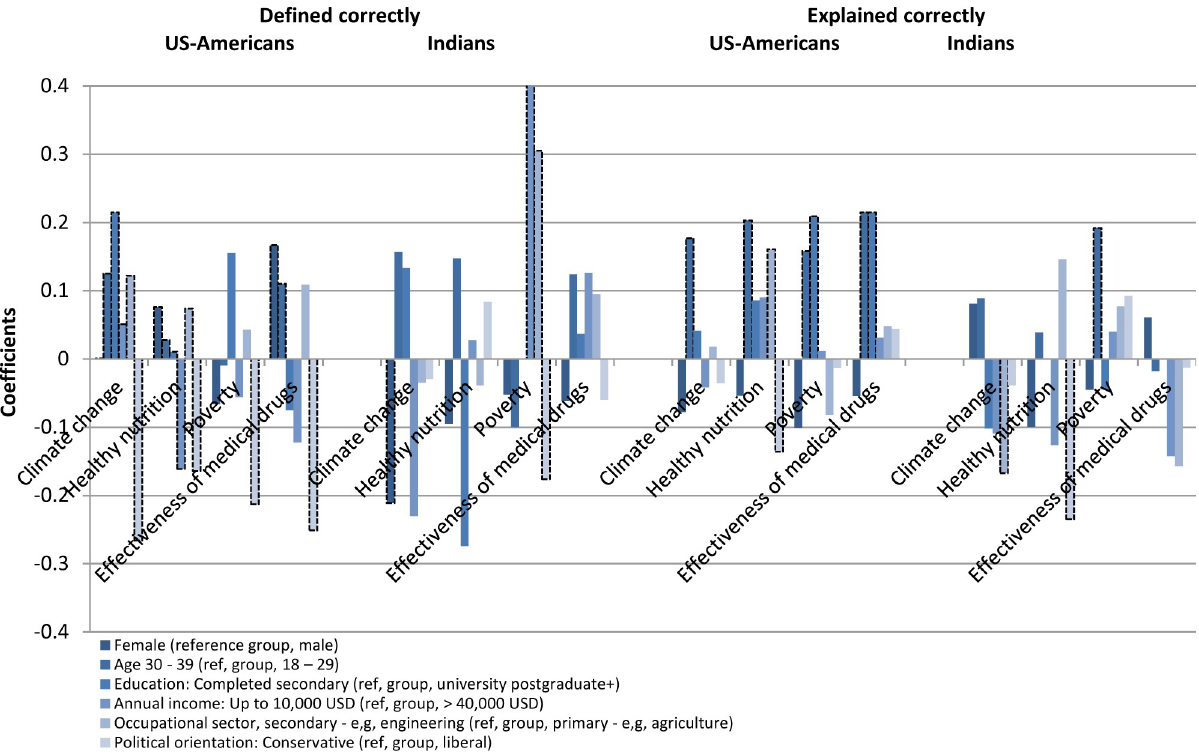
Fig 3. Estimated marginal effects of the traits and conditions of US-Americans and Indians that predict their ability to correctly define and explain climate change, healthy nutrition, poverty and effective medical drugs. Statistically significant coefficients at p < 0.1 or higher are reflected with a black dashed